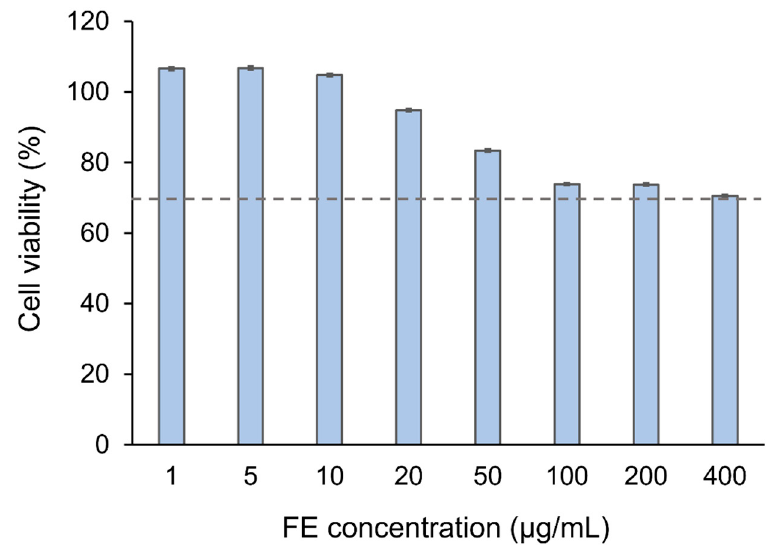
Figure 10. CV of SIRC cells after incubation with FE eye drop suspensions (F6).